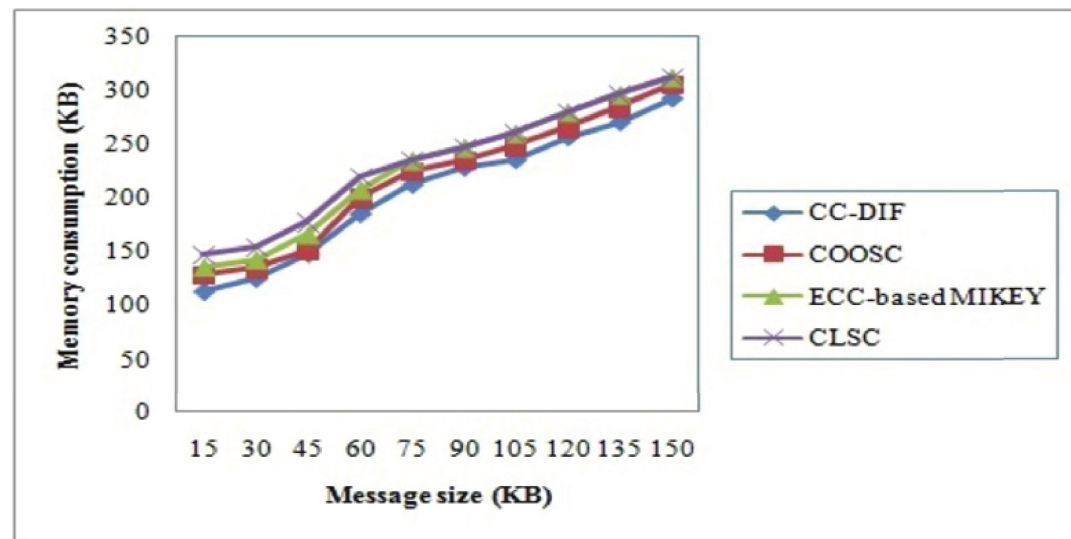
Fig 4. Memory consumption of CC-DIF and three existing